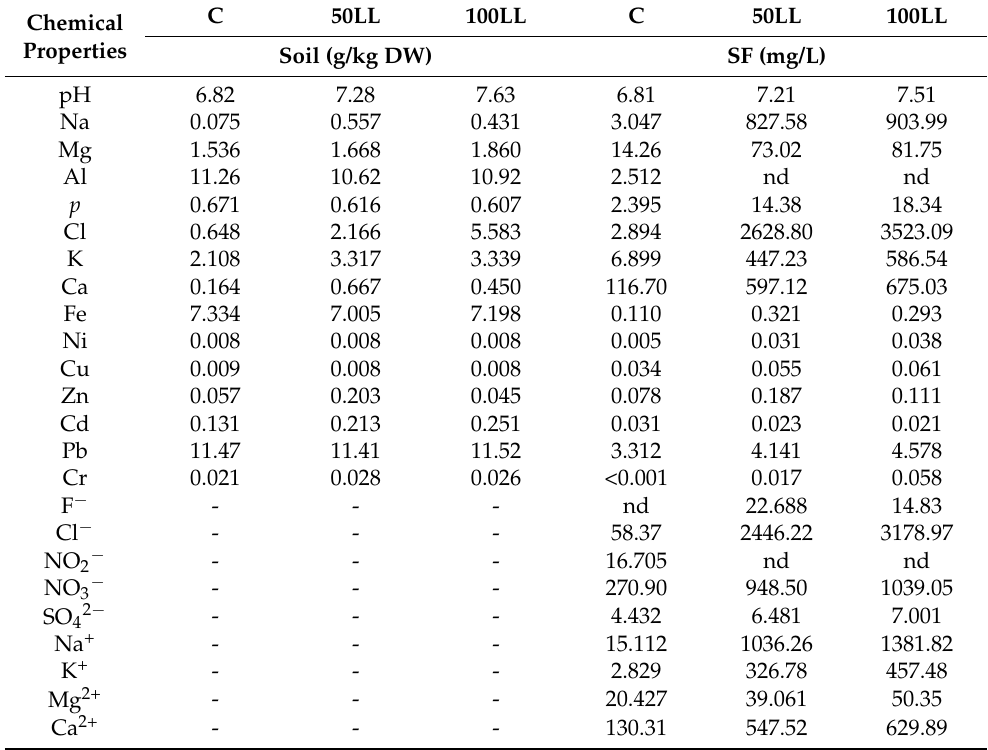
Table 1. Physicochemical properties of soil and